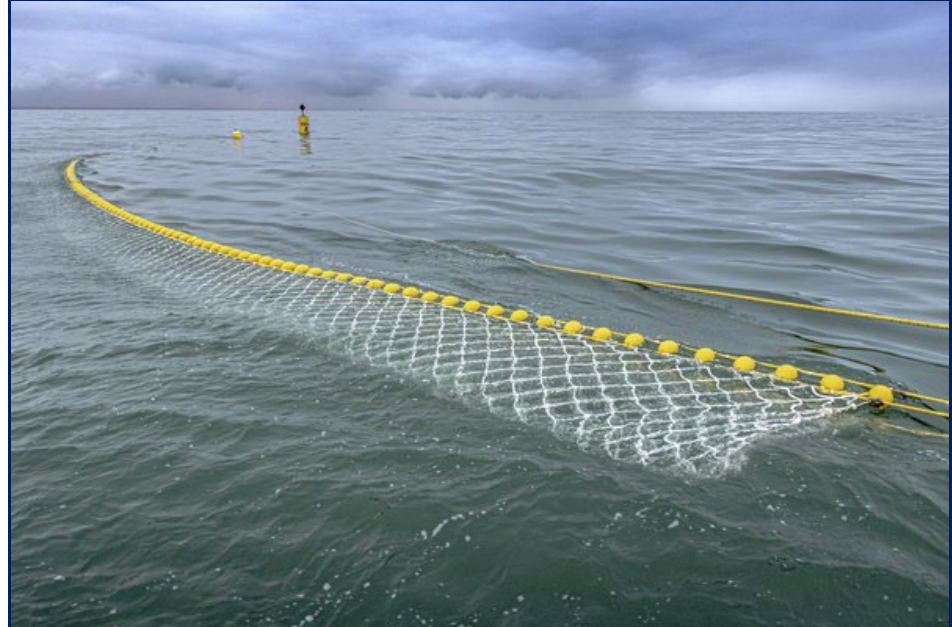
Figure 20. “Cultivator” system under testing in North Sea, https://www.northseafarmers.org/news/210518updateots (accessed on 22 September 2022).